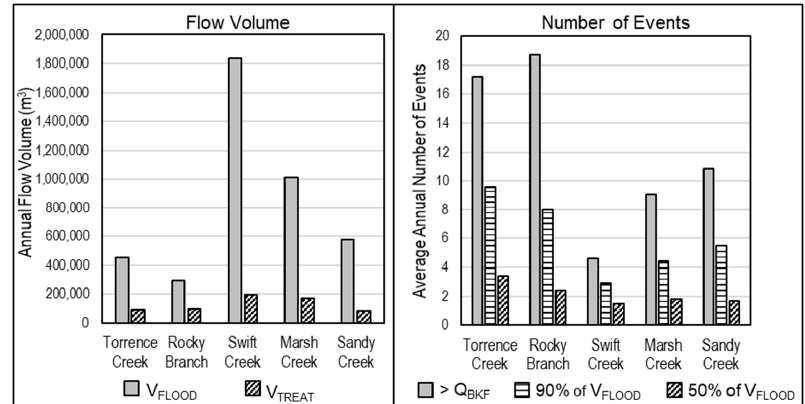
Figure 4. Comparison of the average annual floodplain flow volume (V FLOOD ) to the average annual floodplain volume that could potentially be treated (V TREAT ) ( left ) and a comparison of the number of bankfull events to the number of events in which 50% and 90% of the total V FLOOD occurs ( right ).